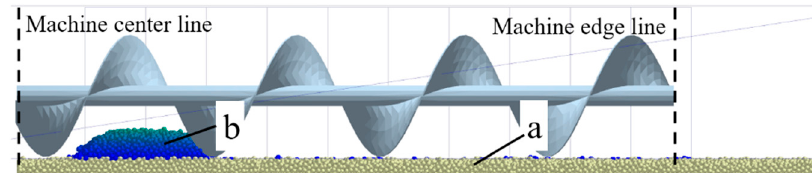
Figure 4. Discrete element simulation model diagram.